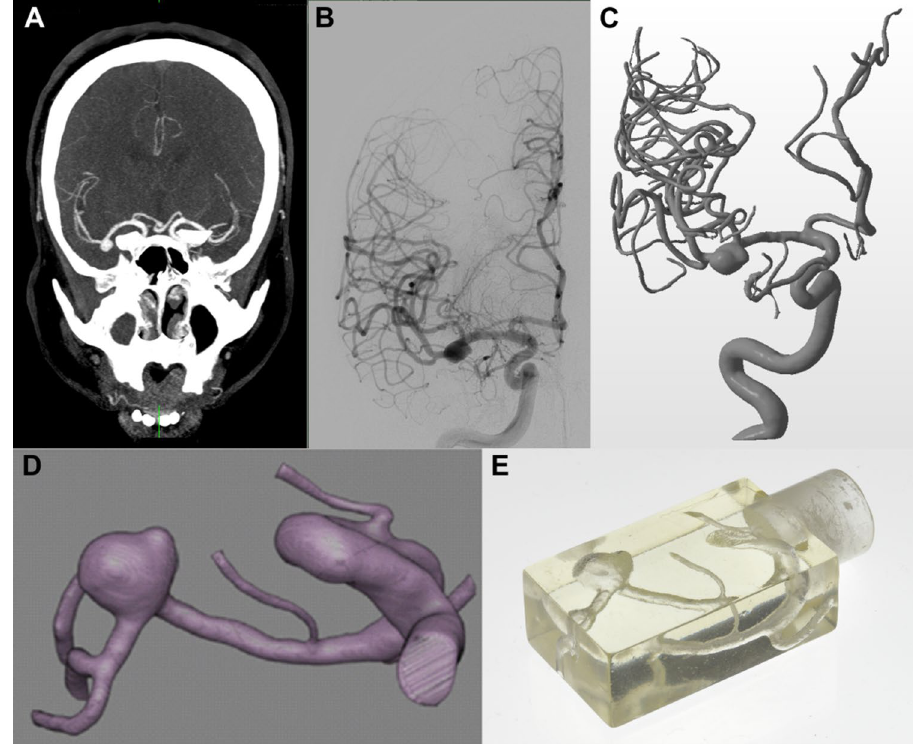
Figure 2. Aneurysm phantom. The aneurysm is located at the right middle cerebral artery and indicated by the blue arrow. ( A ) The patient’s CT image. ( B ) One image from patient’s 3D rotational angiography images. ( C ) 3D rendered representation of the patient’s rotational angiography. ( D ) For further processing, the aneurysm and the access route were isolated as shown by the coronary oblique view. ( E ) The 3D-printed phantom is enclosed by a cuboid and can be attached to the sample holder of the MPI scanner by a plug-in connection.